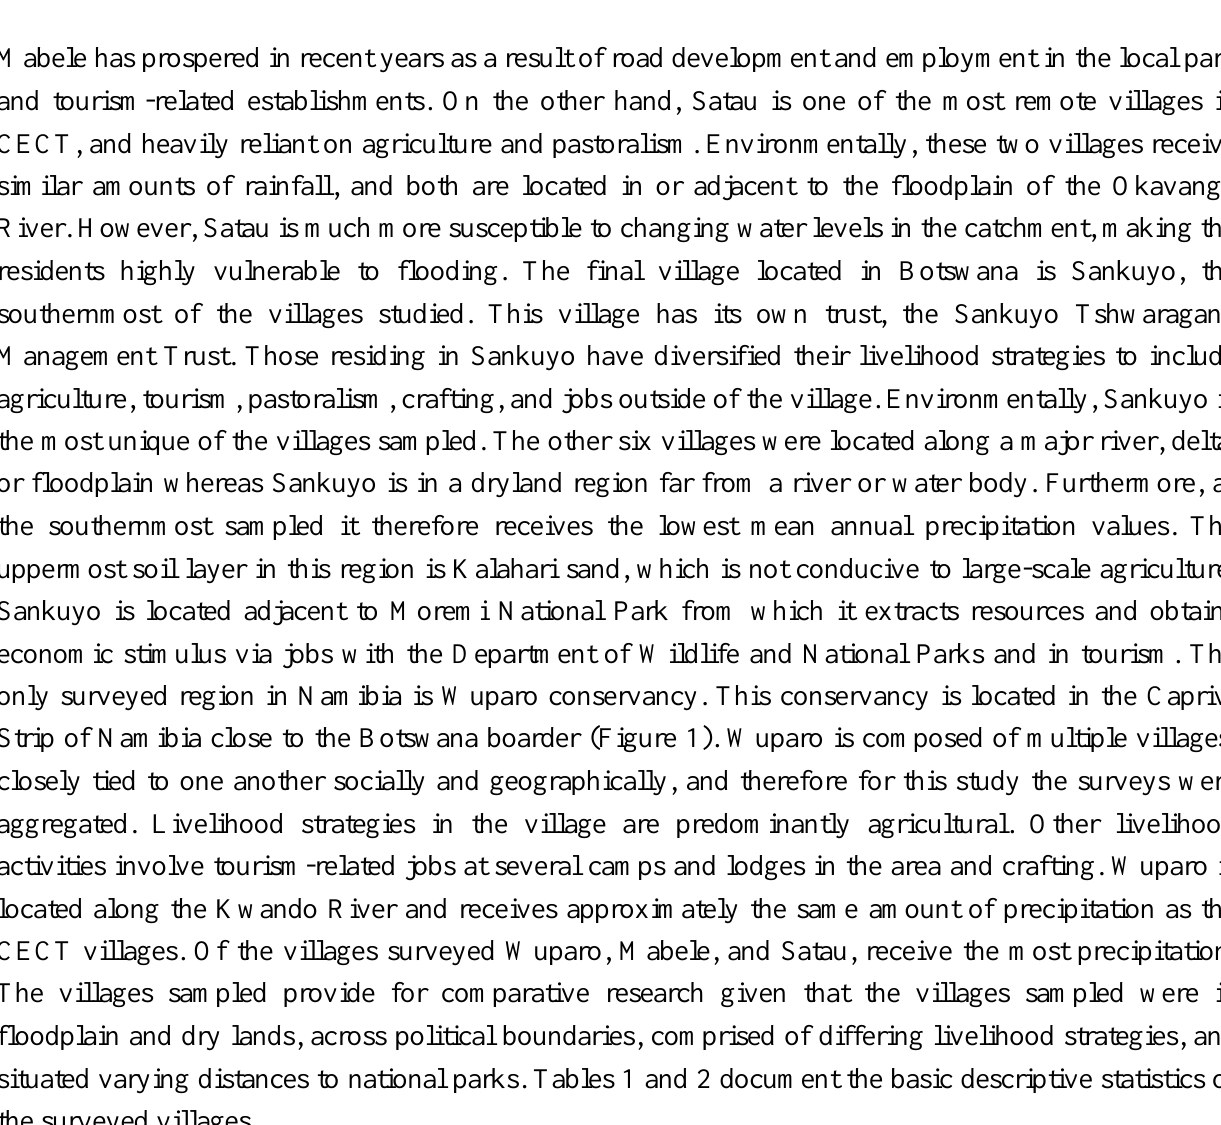
Table 1. Country and village level information in regards to the areas surveyed. Village # of Households Surveyed Country Conservancy/Trust Beetsha 36 Botswana Okavango Conservation Trust Eretsha 37 Botswana Okavango Conservation Trust Mabele 56 Botswana Chobe Enclave Sankoyo 34 Botswana Sankuyo Tshwaragano Management Trust Satau 56 Botswana Chobe Enclave Seronga 49 Botswana Okavango Conservation Trust Wuparo 62 Namibia Wuparo